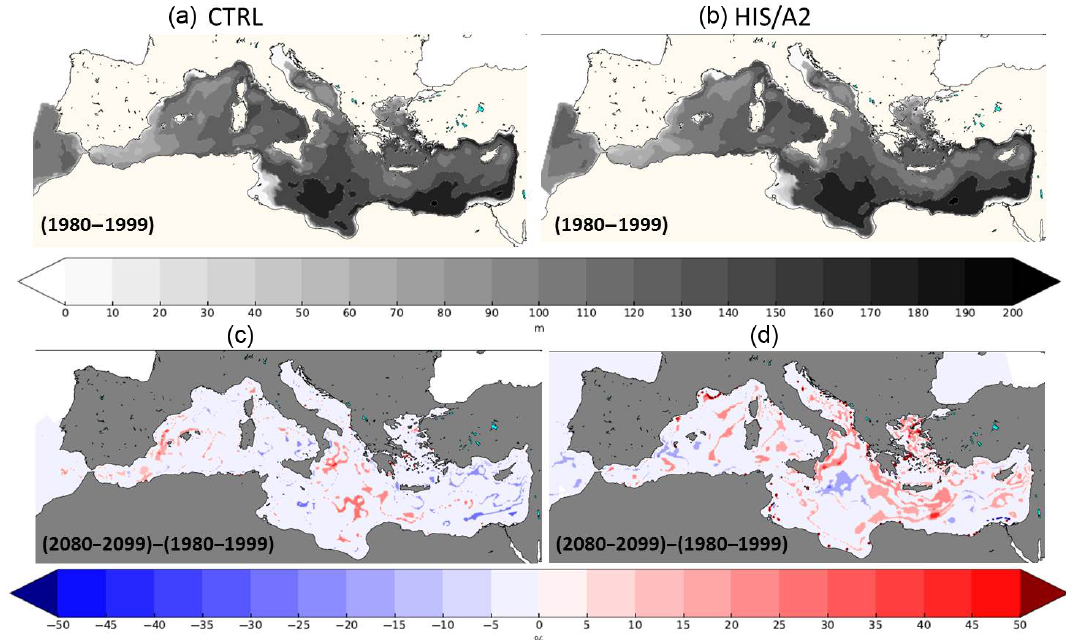
Figure 13. Present (1980–1999, a ) interannual average DCM (m) in the CTRL (a, c) and HIS/A2 (b, d) simulations. The bottom maps show the percentage of relative difference in DCM between the 2080–2099 and the 1980–1999 periods in the CTRL (a, c) and HIS/A2 (b, d) simulations. Table 4. Simulated integrated Chl a (10 9 mol) over 20-year periods in the Mediterranean sub-basins in the different simulations. Basins are the same as defined in Fig. 2 of Adloff et al. (2015), with the eastern basin including the Ionian, Levantine, Adriatic, and Aegean sub-basins. Values in parenthesis indicate the percentage difference from the 1980–1999